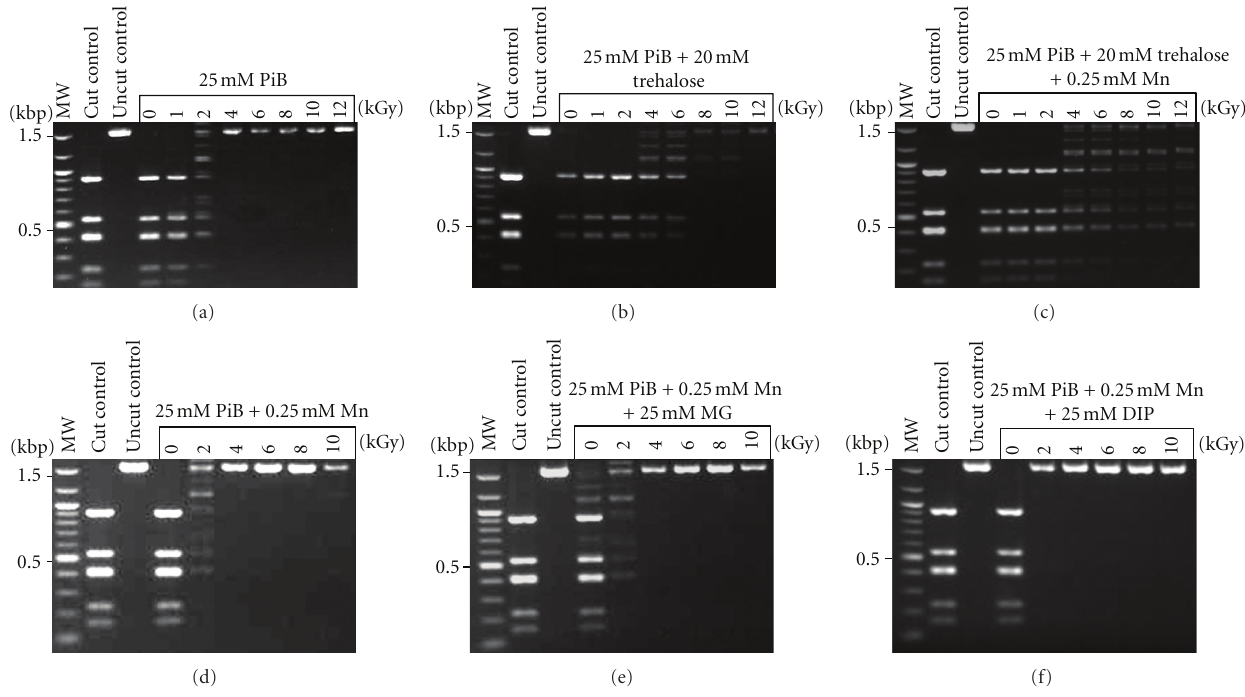
Figure 2: Protection of enzyme activity with compatible solutes under aerobic conditions. In upper panels, the restriction enzyme Dde I was irradiated up to 12kGy with 25mM phosphate bu ff er (PiB) and the addition of 20 mM trehalose and 0.25 mM Mn 2+ . In lower panels, the enzyme was irradiated up to 10kGy, with 25mM PiB combined with 0.25 mM Mn 2+ , with the addition of 25mM MG or DIP. Residual restriction enzyme activity was assayed by the digestion of pUC19 plasmid DNA; fragments were analyzed by agarose gel electrophoresis. The first lanes are molecular size